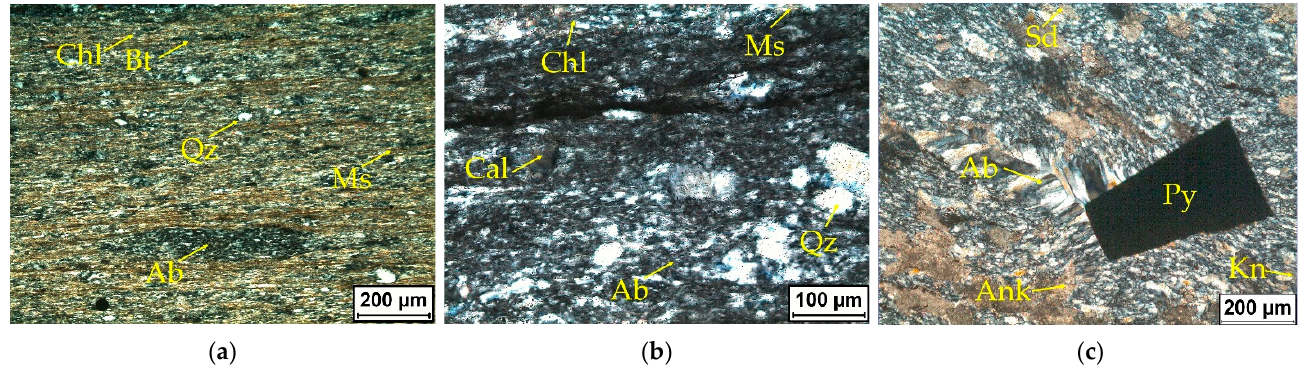
Figure 3. Photomicrograph of: ( a ) Least altered phyllite ( b ) Albite–chlorite alteration zone, and ( c ) Albite–ankerite–pyrite alteration zone. Abbreviations: Ab = albite, Ank = ankerite, Bt = biotite, Cal = calcite, Chl = chlorite, Kln = kaolinite, Ms = muscovite, Py = pyrite, Qz = quartz, Sd = siderite. Samples from the albite–chlorite alteration zone are strongly foliated and cross-cut by thin quartz–calcite veins and veinlets. The mineralogical composition of the albite– chlorite alteration is predominantly albite followed by chlorite, calcite, muscovite